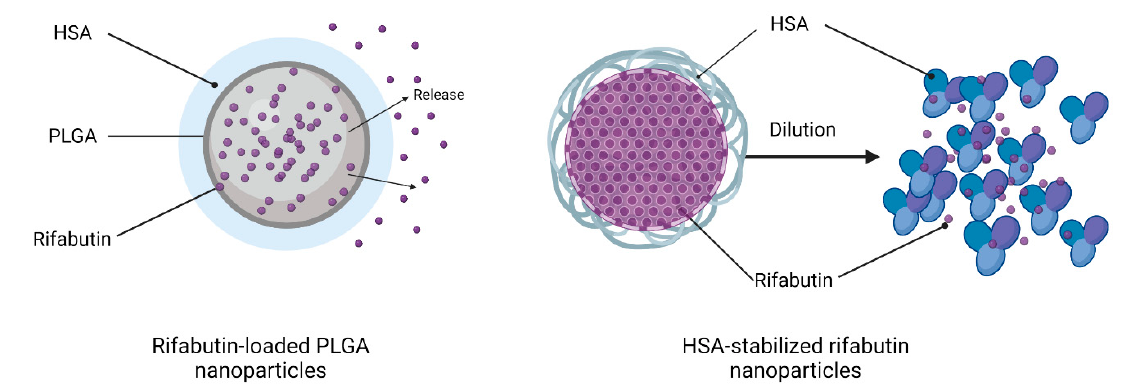
Figure 2. Structure of the two formulation prototypes including rifabutin-loaded PLGA nanoparticles ( left ) and HSA-stabilized rifabutin nanoparticles ( right ). While the PLGA particles provide a stable matrix structure, HSA-stabilized rifabutin nanoparticles disassemble into smaller particles when diluted with water. Created with BioRender.com. https://app.biorender.com/ (accessed on 22 February 2023)